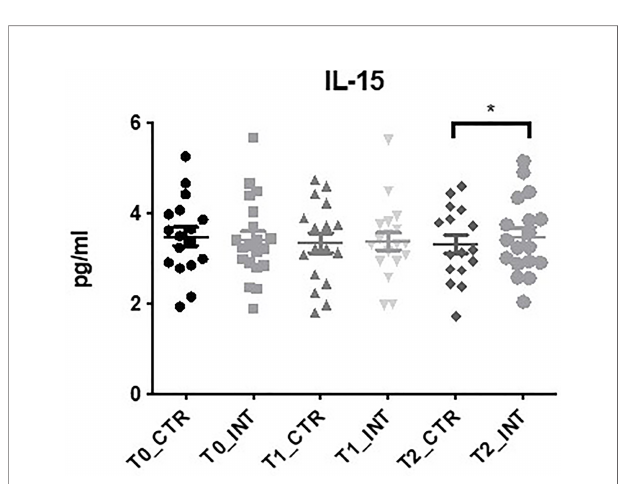
FIGURE 5 | Exercise intervention increases IL-15 expression at T2. Data at immediately post 12-week intervention (Time 1; T1) and at 3-month follow-up (Time 2; T2) was analyzed using linear regression models, adjusting for baseline values (T0). A signi fi cant increase in serum IL-15 expression was observed at T2 between control and intervention cohorts (*p ≤